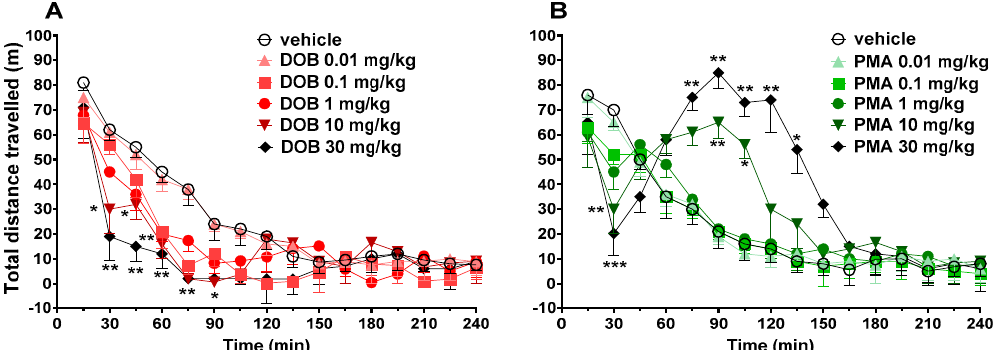
Figure 5. Effect of DOB (0.01–30 mg/kg i.p.; panel A ) and PMA (0.01–30 mg/kg i.p.; panel B ) on the total distance travelled of mice in 4-hour observation. Data are expressed as meters travelled and represent the mean ± SEM of 8 determinations for each treatment. Statistical analysis was performed by two-way ANOVA followed by Bonferroni’s test for multiple comparisons for the dose–response curve of each compound at different times. * p < 0.05, ** p < 0.01 and *** p < 0.001 versus vehicle.